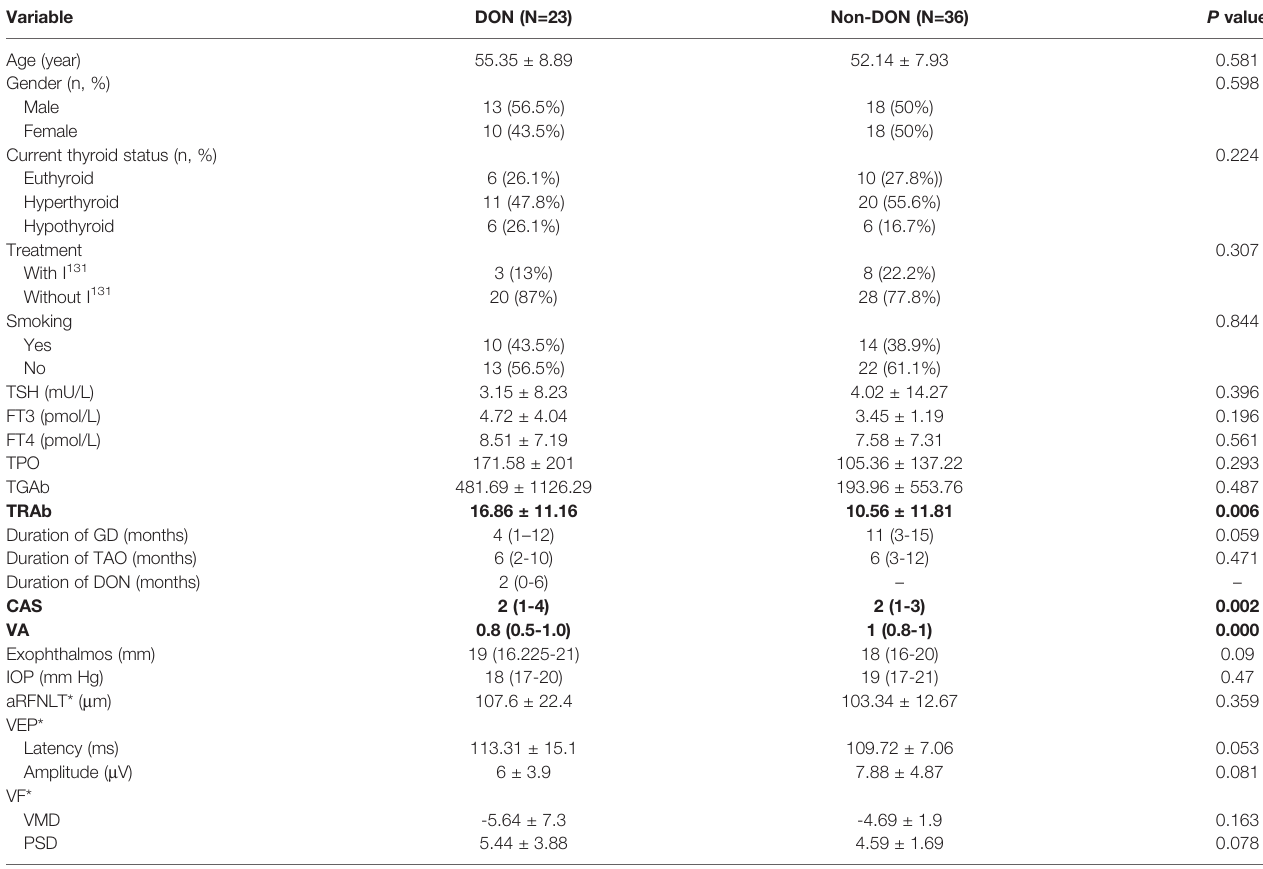
TABLE 1 | Univariate analysis of the detailed clinical and demographic information of study population.